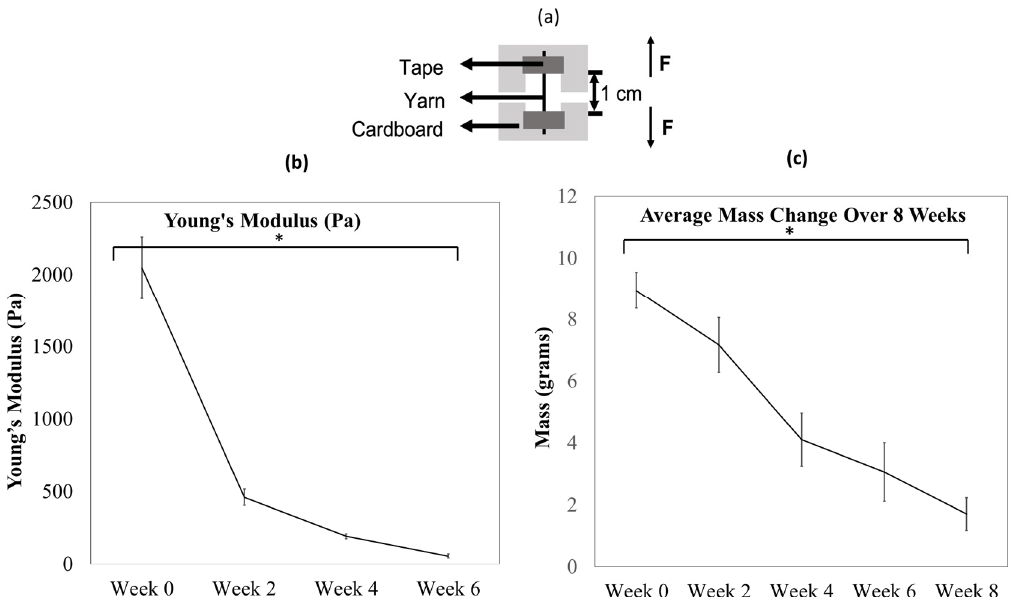
Figure 3. Mechanical analysis over time: Collagen yarns were soaked in a collagenase solution for 8 weeks ( n = 3 samples per period). Samples were prepared and mounted using a cardboard holder ( a ) for tensile testing. The samples showed a significant loss (97%, * p < 0.0001) in strength over 6 weeks. After 6 weeks, the samples lost mechanical integrity and therefore could not be tested further. There was a significant mass reduction * ( p < 0.0001) from week 0 to week 8. ( b ) Mass change was calculated and recorded over time for the material degradation analysis. In the study, 20/s yarns were soaked in collagenase solution for 8 weeks, ( n = 6 per period) and an average mass loss of 80 ± 6% was recorded over 8 weeks. Standard deviation is shown by error bars ( c ).